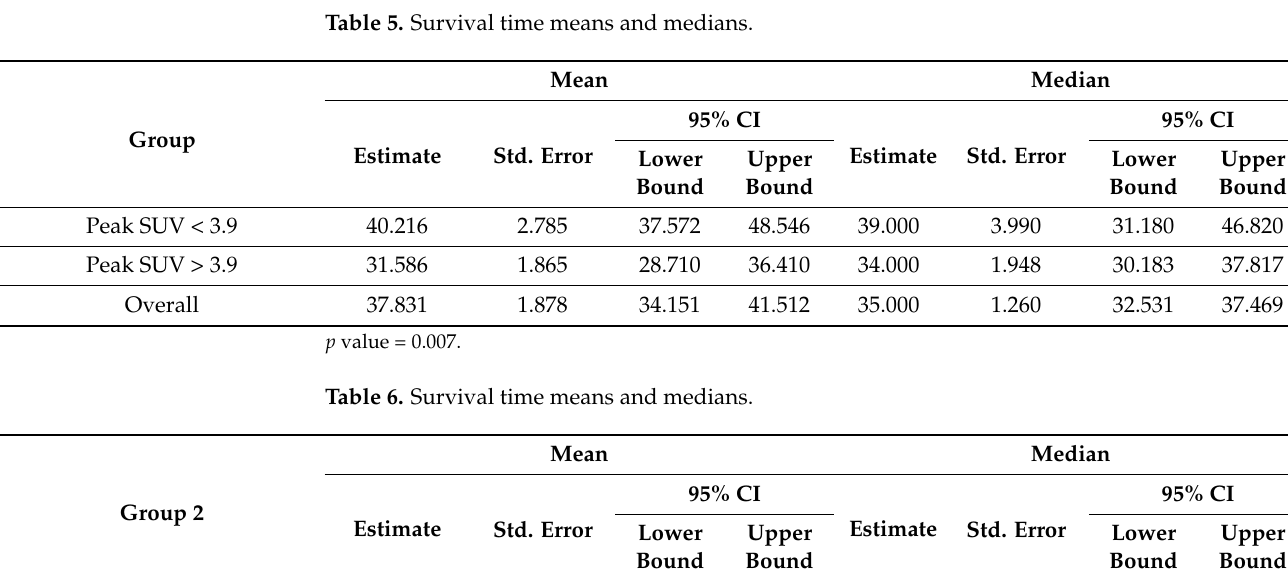
Table 7. Correlation between serum MMP-2 and the patients’ characteristics.